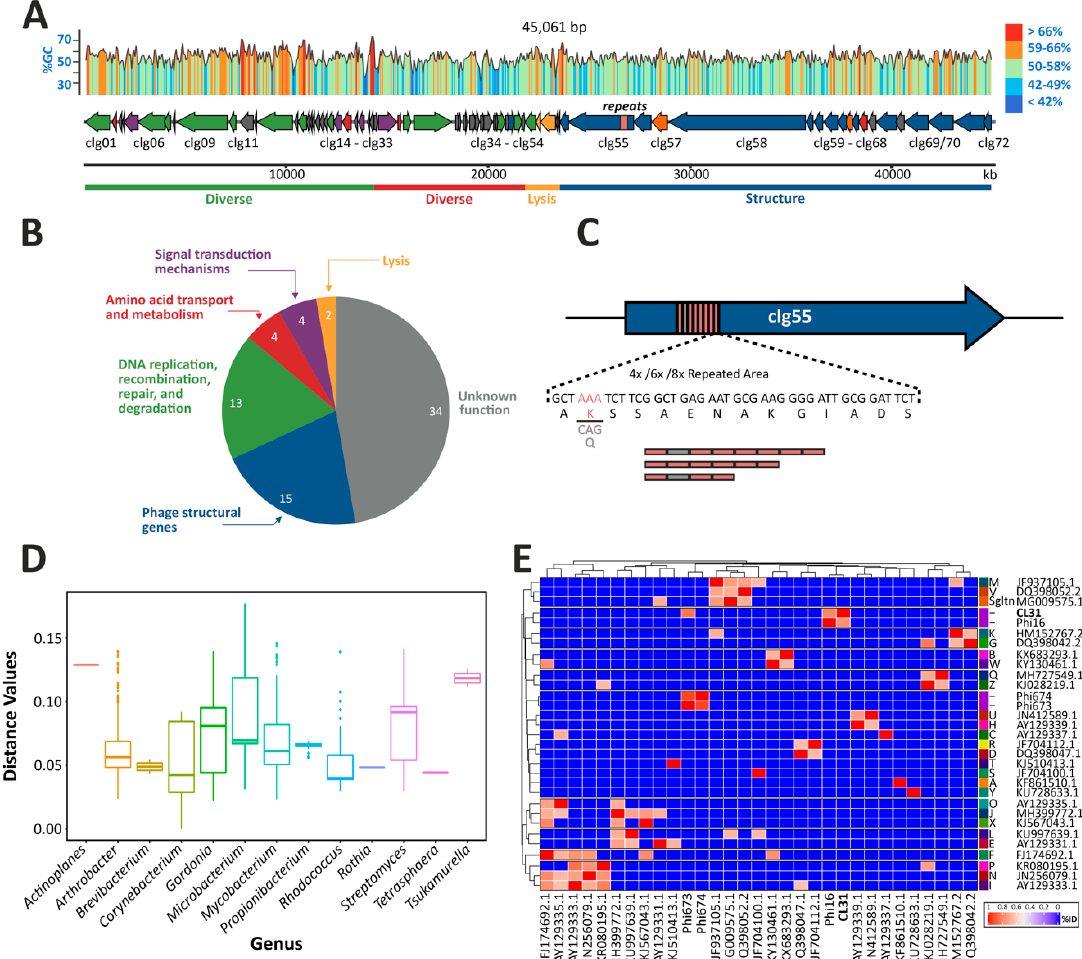
Figure 1. Genome analysis of the corynephage CL31. ( A ) The genome of CL31 was assembled based on a combination of Illumina sequencing and Sanger sequencing. Gene prediction was done using Phanotate, GeneMark, and SnapGene. The annotation and functional categorization ( B ) are based on multiphate as well as BLASTp against nr database and the PhagesDB database (phagesdb.org). ( C ) The gene clg55 contains a variable repeat region consisting of 42 base pair minisatellites. This region could not be assembled using formerly described assembly methods but was resolved by Sanger sequencing. ( D ) Pairwise distance between CL31 and >2950 phage genomes based on the Jensen-Shannon divergence method ( E ) Heatmap representing an average nucleotide percentage identity matrix with distances obtained using PYANI with the BLAST (ANIb) method based on a selected set of 31 phage genomes, including CL31.